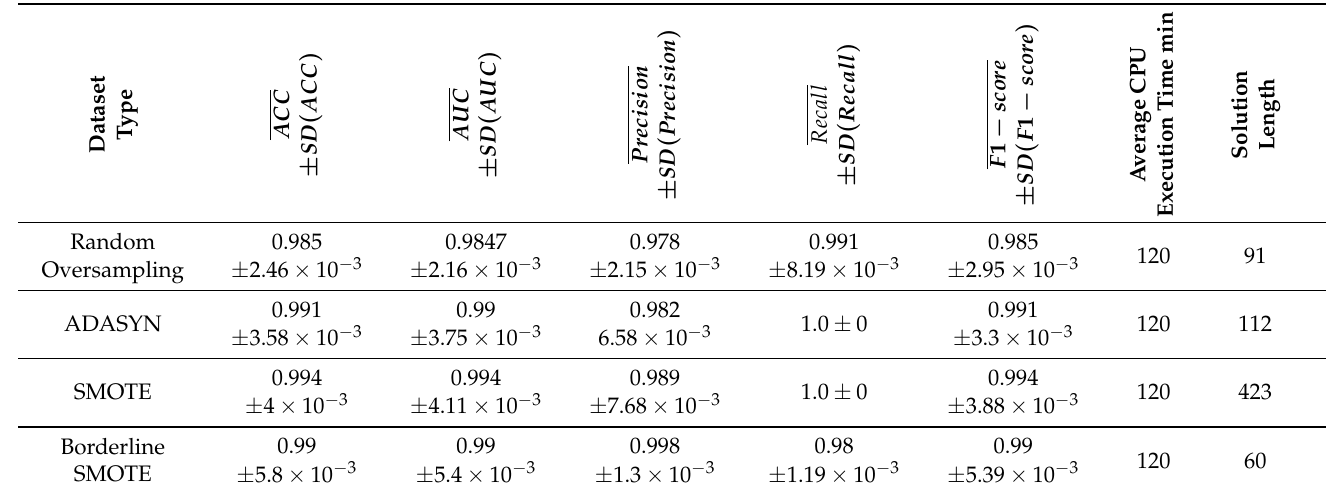
Table 4. The numerical values of mean ACC, AUC, Precision, Recall, and F1-Score with standard